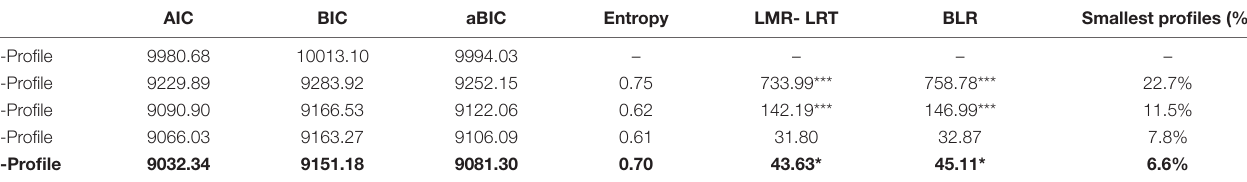
FIGURE 1 | Four mental health profiles based on the z-value of each indicator. N = 1,640. TABLE 4 | The goodness of fit indices for the Dark Triad